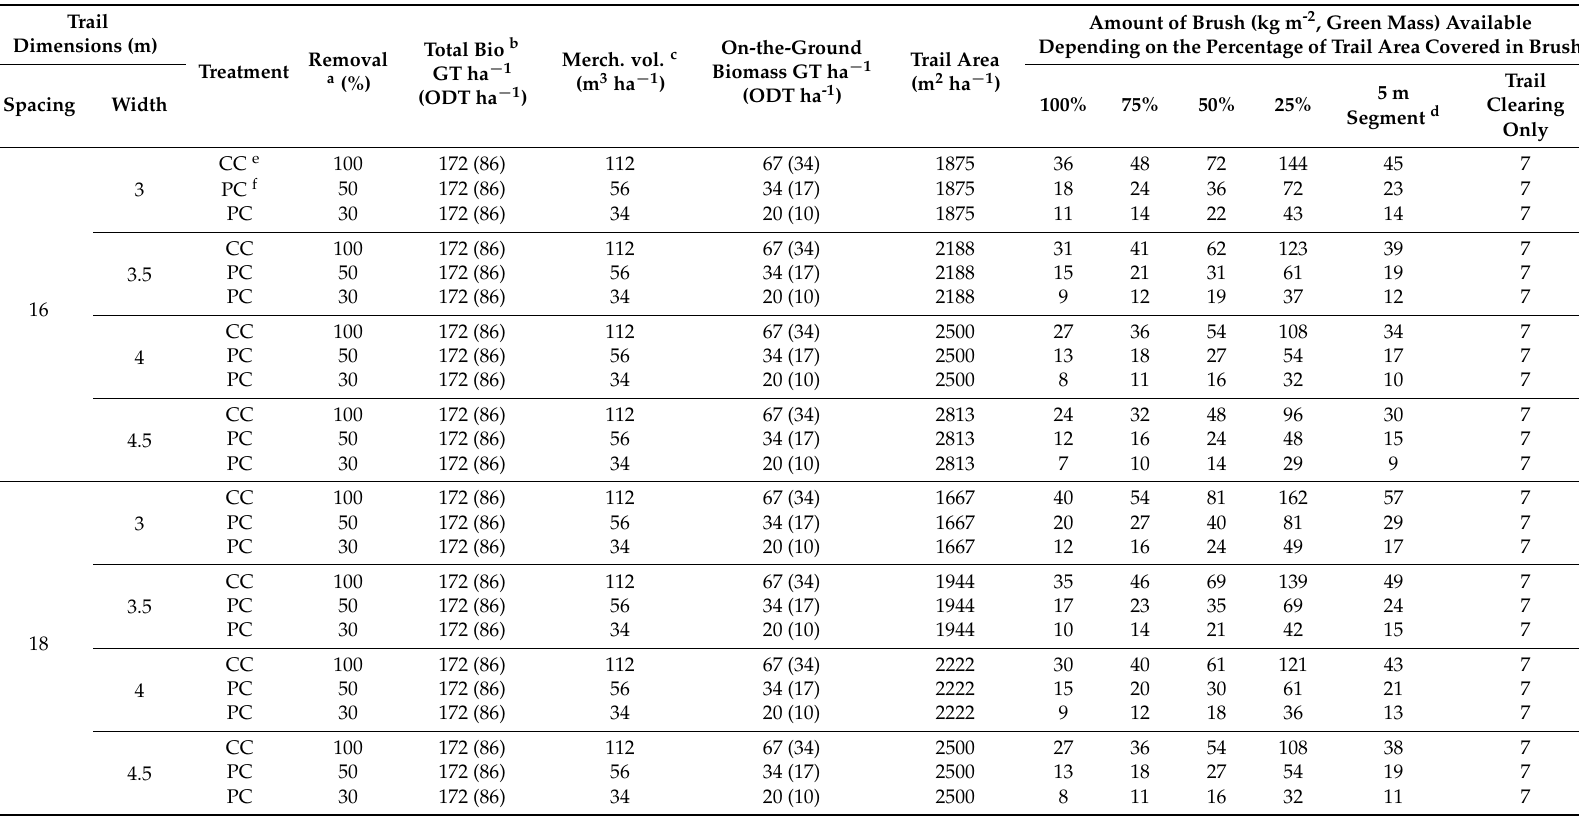
Table A4. Amount of brush available for soil protection as brush mats depending on trail spacing, trail width and varying trail coverage obtained from a naturally regenerated mixed-wood stand